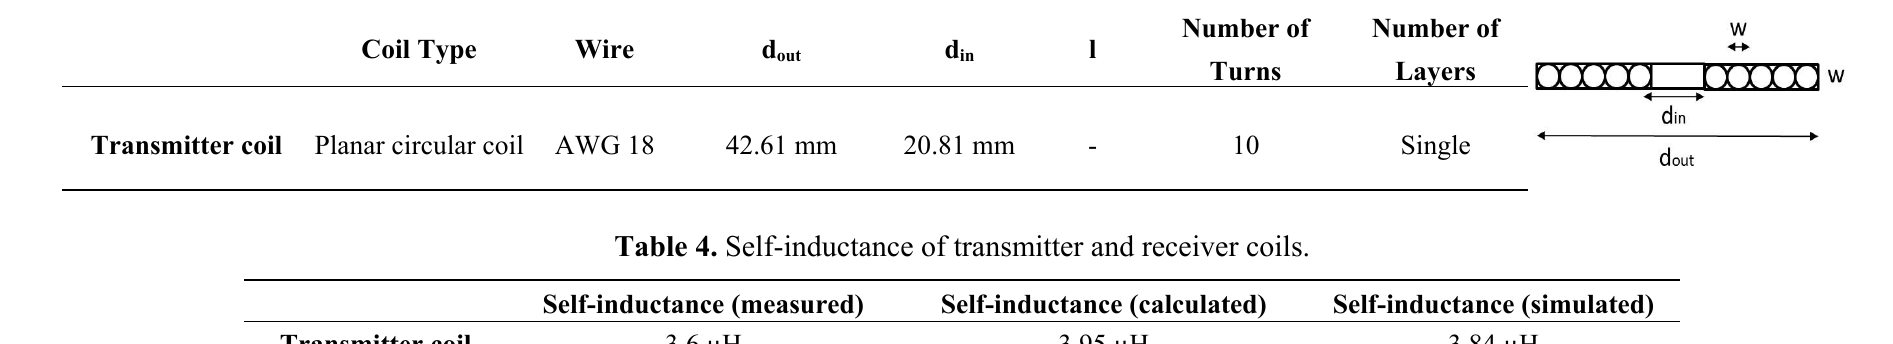
Table 3. Transmitter coil features.